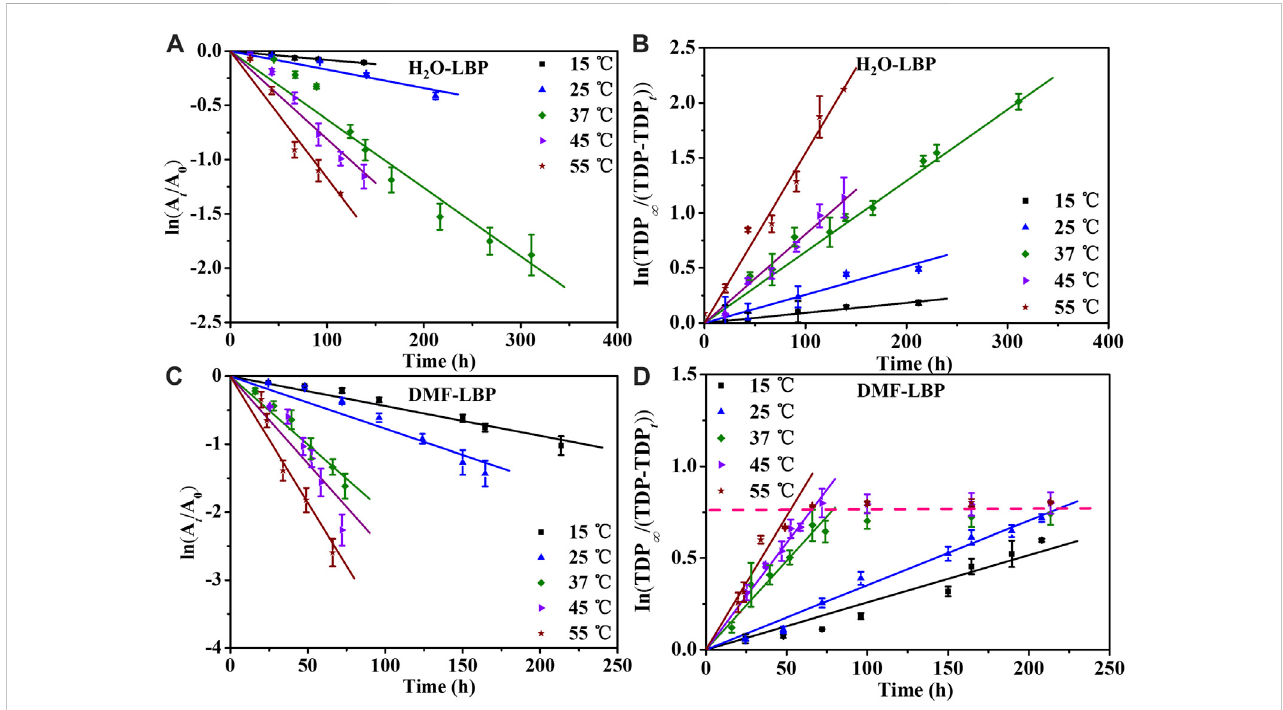
FIGURE 3 Degradation kinetics curves of LBP based on UV absorbance (A, C) and based on TDP (B, D) at pH 8 under different temperatures. A 0 and A t : UV absorbance at time 0 and t ; TDP ∞ : total concentration of P in LBP; TDP t : TDP at time t